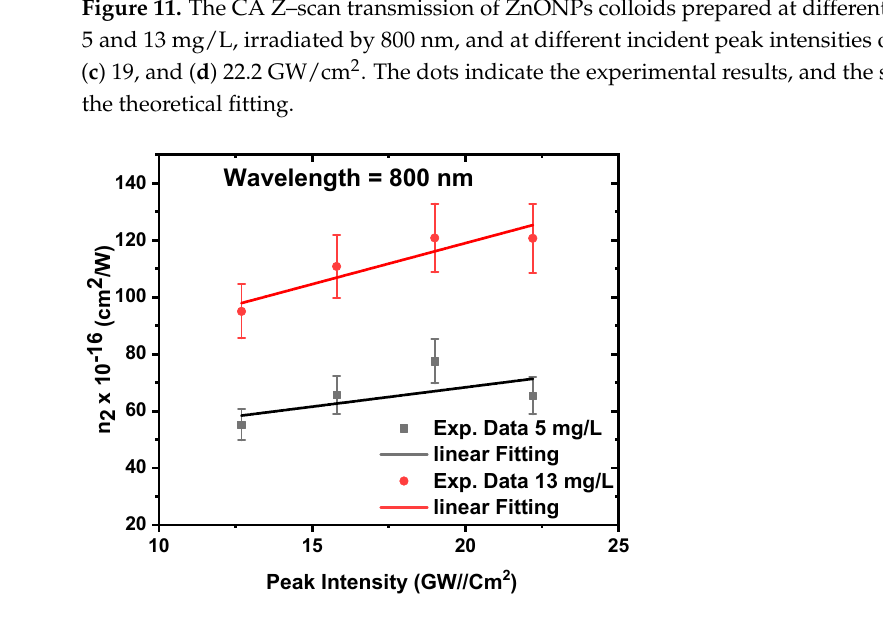
Figure 11. The nonlinear refractive index of ZnONPs colloids as a function of the incident peak intensity at a constant excitation wavelength of 800 nm.